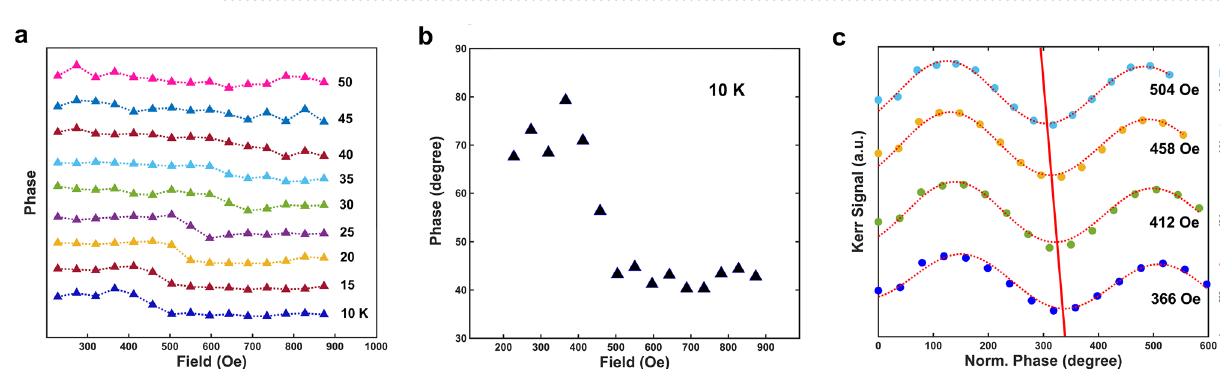
Figure 2. ( a ) Effective Gilbert damping constant as a function of externally applied field at different temperatures from 10 to 50 K. ( b ) Red rectangular solids denote the peak (or strongest if not peak) Gilbert damping from 10 to 50 K. Blue circle solids are the corresponding fields as a function of temperature. ( c ) Illustration of photo-excited exchange-coupling torque and spin-pumping generated dynamic exchange- coupling mode for damping.